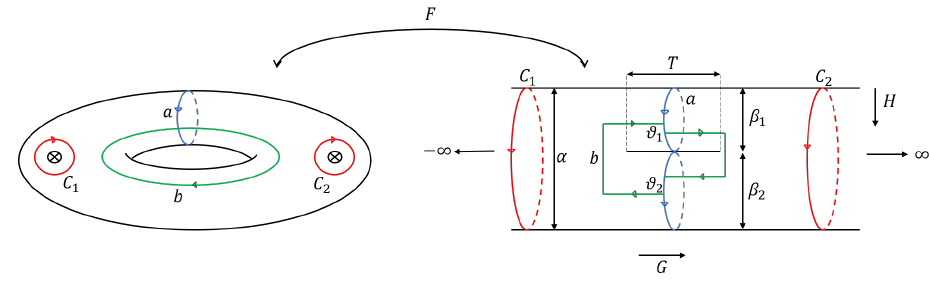
Figure 1 . The torus with two punctures and the corresponding LCD. The Mandelstam map send the punctures over the torus to ±∞ in the